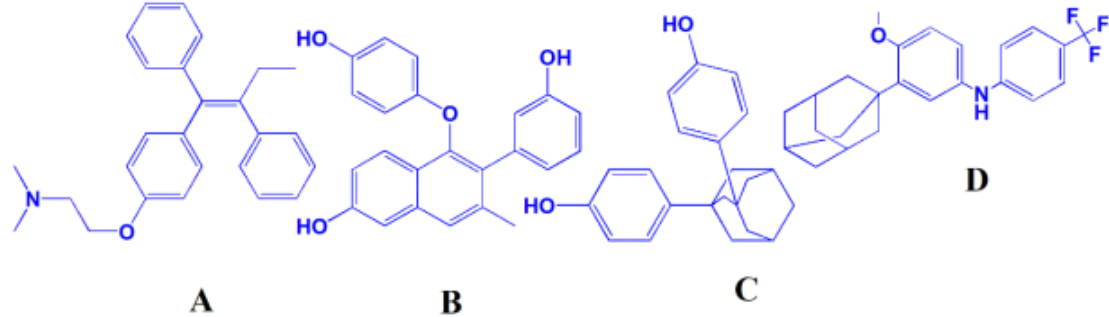
Figure 1. Structures of the oestrogen receptor (ER) modulators used as ER ligands: ( A ) tamoxifen; ( B ) 5-(4-hydroxyphenoxy)- 6-(3-hydroxyphenyl)-7- methylnaphthalen-2-ol; ( C ) 4,4-(1,3-adamantanediyl) diphenol; ( D ) 3-(adamantan-1-yl)-4-methoxy- N-(4-(trifluoromethyl) phenyl)